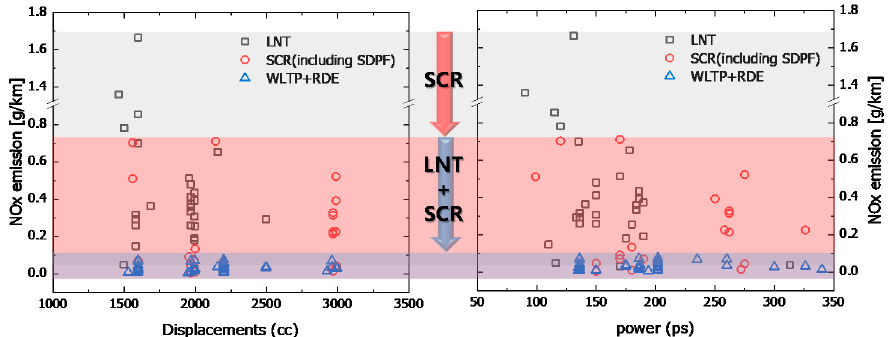
Figure 11. NO x emission characteristics on RDE test of light duty diesel vehicles with EURO-6 emission standard according to the after-treatment system.